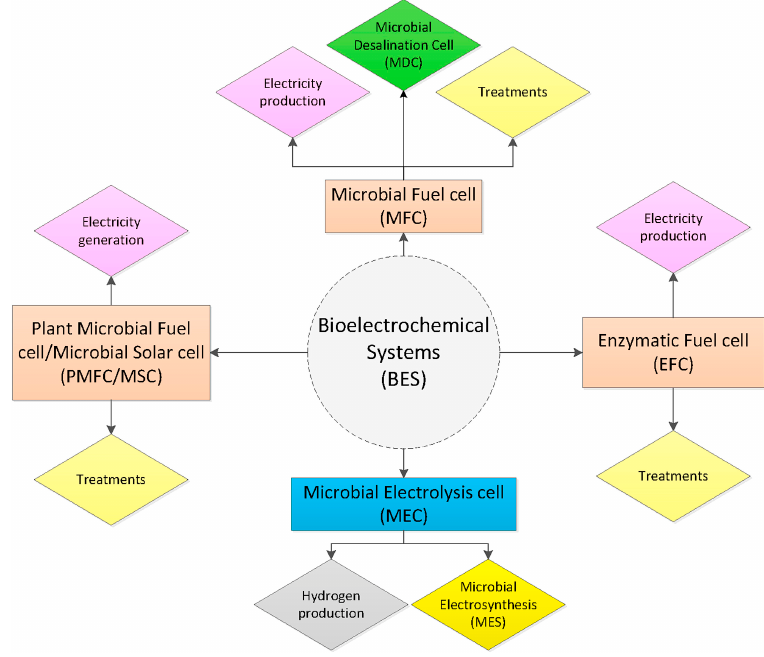
Figure 2. Schematic overview of various types of bio-electrochemical systems (BESs) [11].